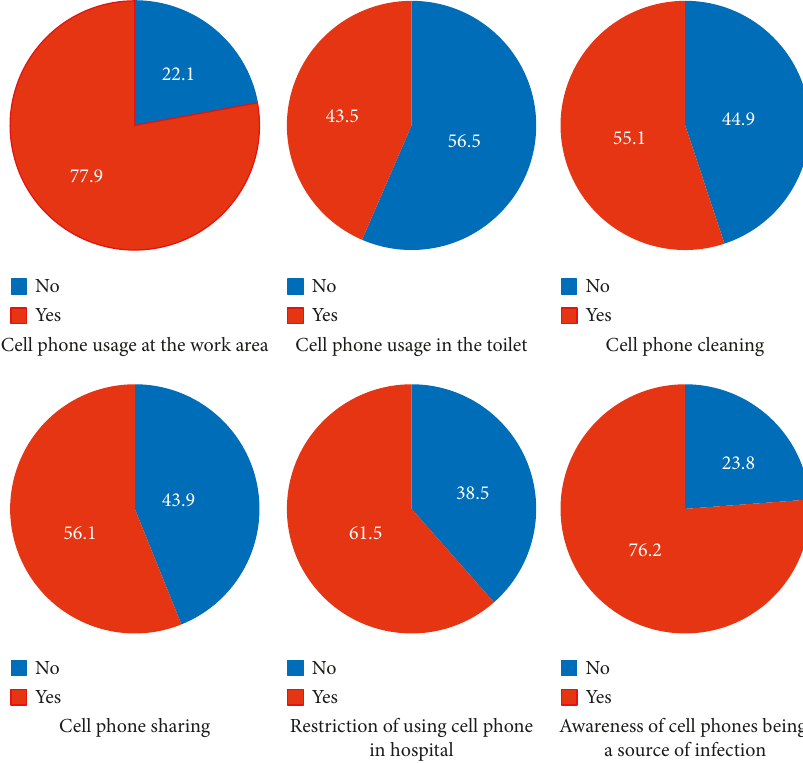
Figure 2: Survey results of cell phone use among healthcare workers ( n � 285) at selected